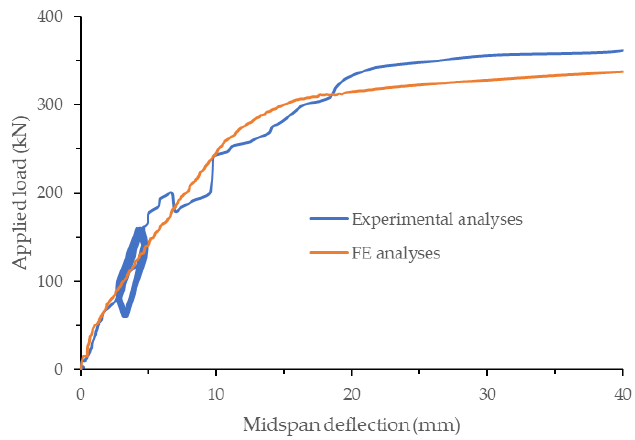
Figure 13. Load-displacement curve for a UHPC layer ratio of 0.6.